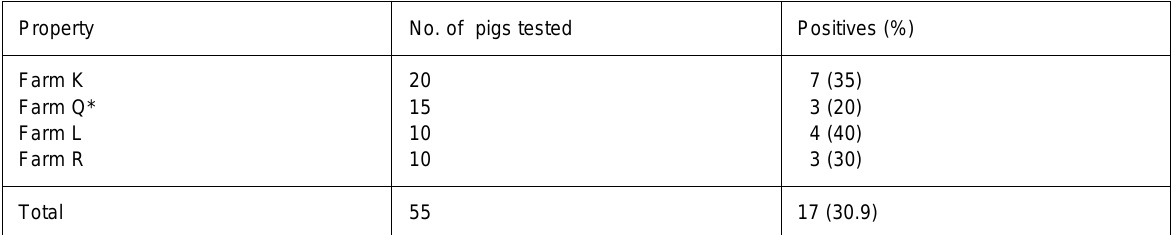
TABLE 2 Prevalence of anti- Toxoplasma gondii IgG IFAT antibodies in culled adult pigs (> 4 years old) from commercial farms Property